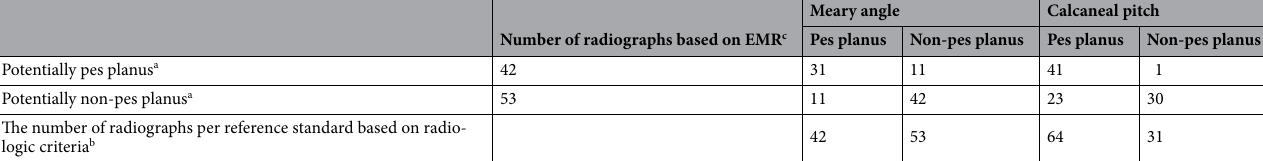
Table 5. Summary of reference standard based on radiologic criteria and electronic medical record. a Diagnosis based on record or electronic medical record. b Diagnosis based on radiologic criteria of Meary angle and calcaneal pitch respectively. c Electronic medical